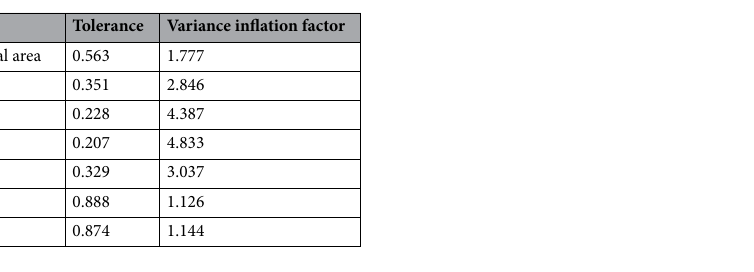
Table 3. Multicollinearity diagnosis of driving factors.